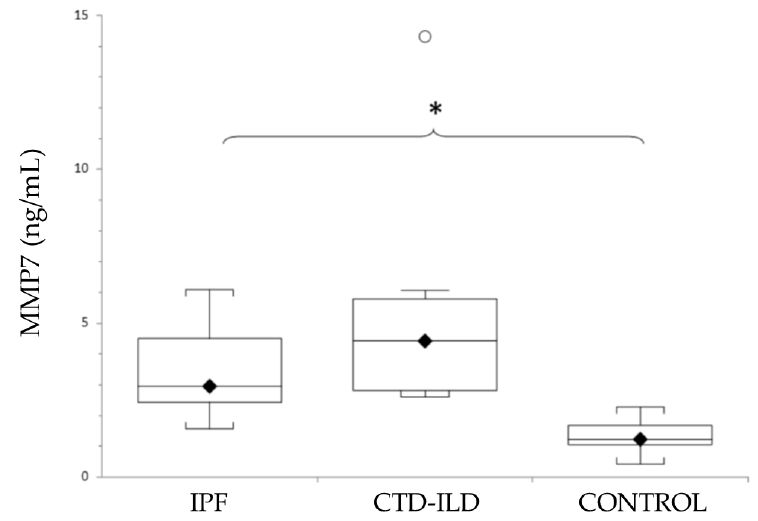
Figure 2. Levels of MMP7 in patients with IPF, CTD-ILD and healthy controls, expressed as mean ± SEM. Results were compared using one-way ANOVA with Tukey’s post hoc test. MMP7: Matrix metalloproteinase 7. IPF: Idiopathic pulmonary fibrosis. CTD-ILD: Connective tissue disease-interstitial lung disease. White circles represent outliers. *: p < 0.05. *: Patients versus healthy controls.